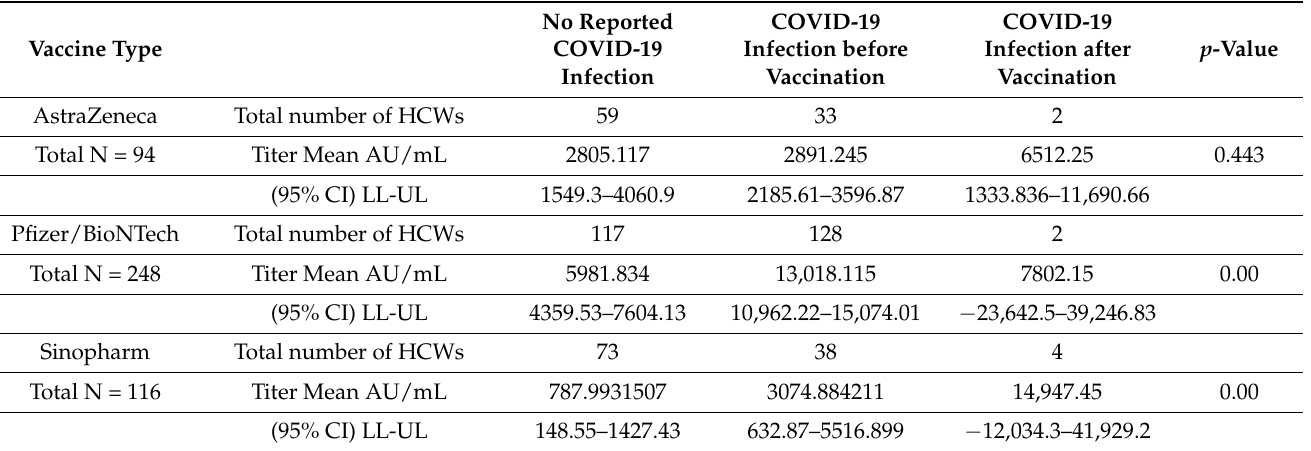
Table 6. The effect of the time of acquiring COVID-19 infection on the mean titer of neutralizing IgG antibodies in HCWs vaccinated with three main types of vaccines.